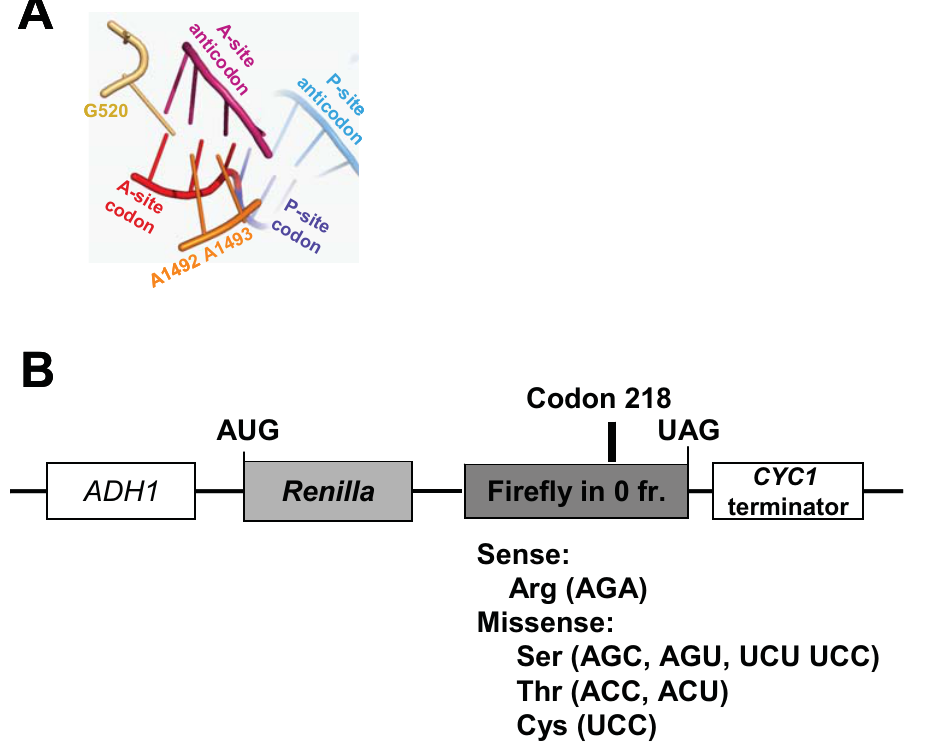
Figure 1. The decoding center and dual-luciferase reporters for determining rates of translational misreading in yeast. Panel A. The codon:anticodon mini-helix in the decoding center is stabilized by base-pairing at all three positions of the mini-helix favoring A-minor interactions with flipped out bases G520, A1492 and A1493. PyMol (Delano Scientific, LLC) was used to generate this figure based on the coordinates 1IBM in the RSCN Protein Data Bank [40]. Panel B. In all missense reporters, transcription is initiated from the yeast ADH1 promoter, and terminated at a sequence from the CYC1 3 9 UTR. The luciferase genes from Renilla and firefly are cloned in frame to produce a fusion of the two proteins. The sense reporter has the AGA codon encoding arginine at amino acid residue 218 in the catalytic site of firefly luciferase. Missense reporters contain the indicated mutations at this position, which encode the indicated amino acids. Efficiencies of missense suppression were calculated by dividing the ratio of firefly/Renilla luciferase generated from cells harboring the missense test vectors by the ratio of firefly to Renilla luciferase generated from cells harboring the sense control plasmid.